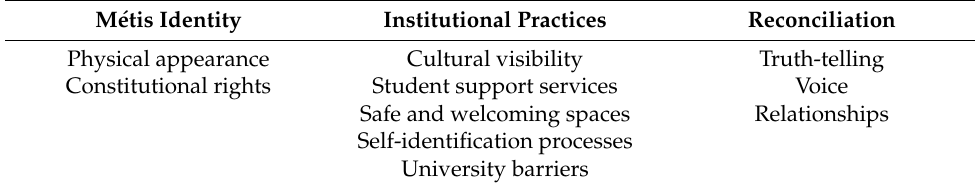
Table 1. Categories and